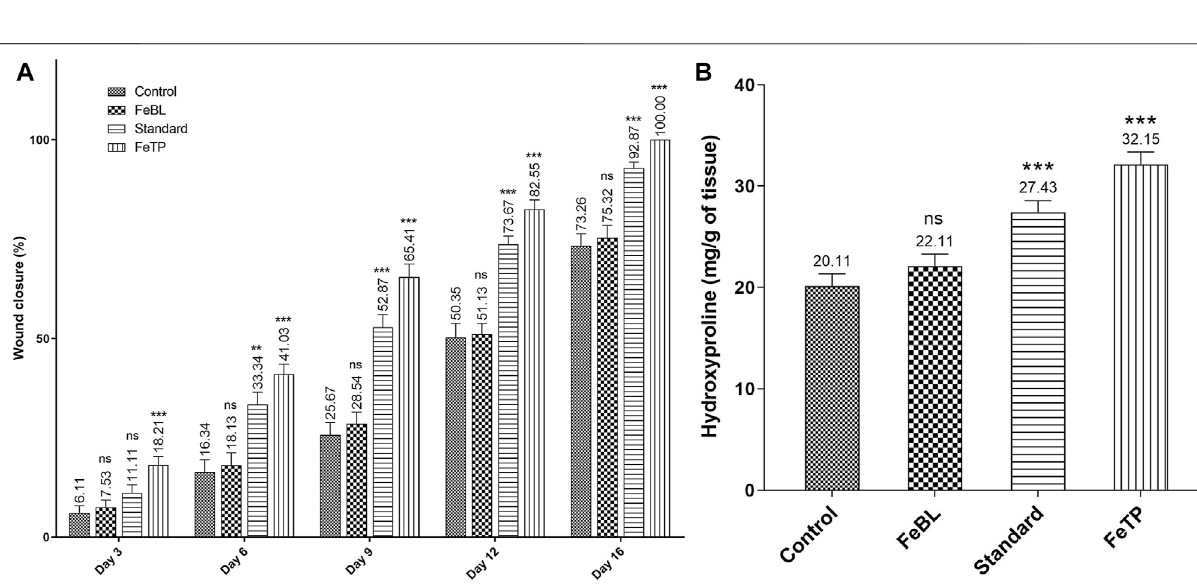
FIGURE 4 | Effect of FeTP on excision wound expressed as (A) % wound closure and (B) hydroxyproline content. Values are represented as mean ± SEM (n (cid:2) 6). Datawere analyzed by one-way ANOVA followed by Dunnett ’ s test. Mean values are shown above bar and error bar. Signi fi cantdifference ** p < 0.01, *** p < 0.001, and ns: non-signi fi cant in comparison to control